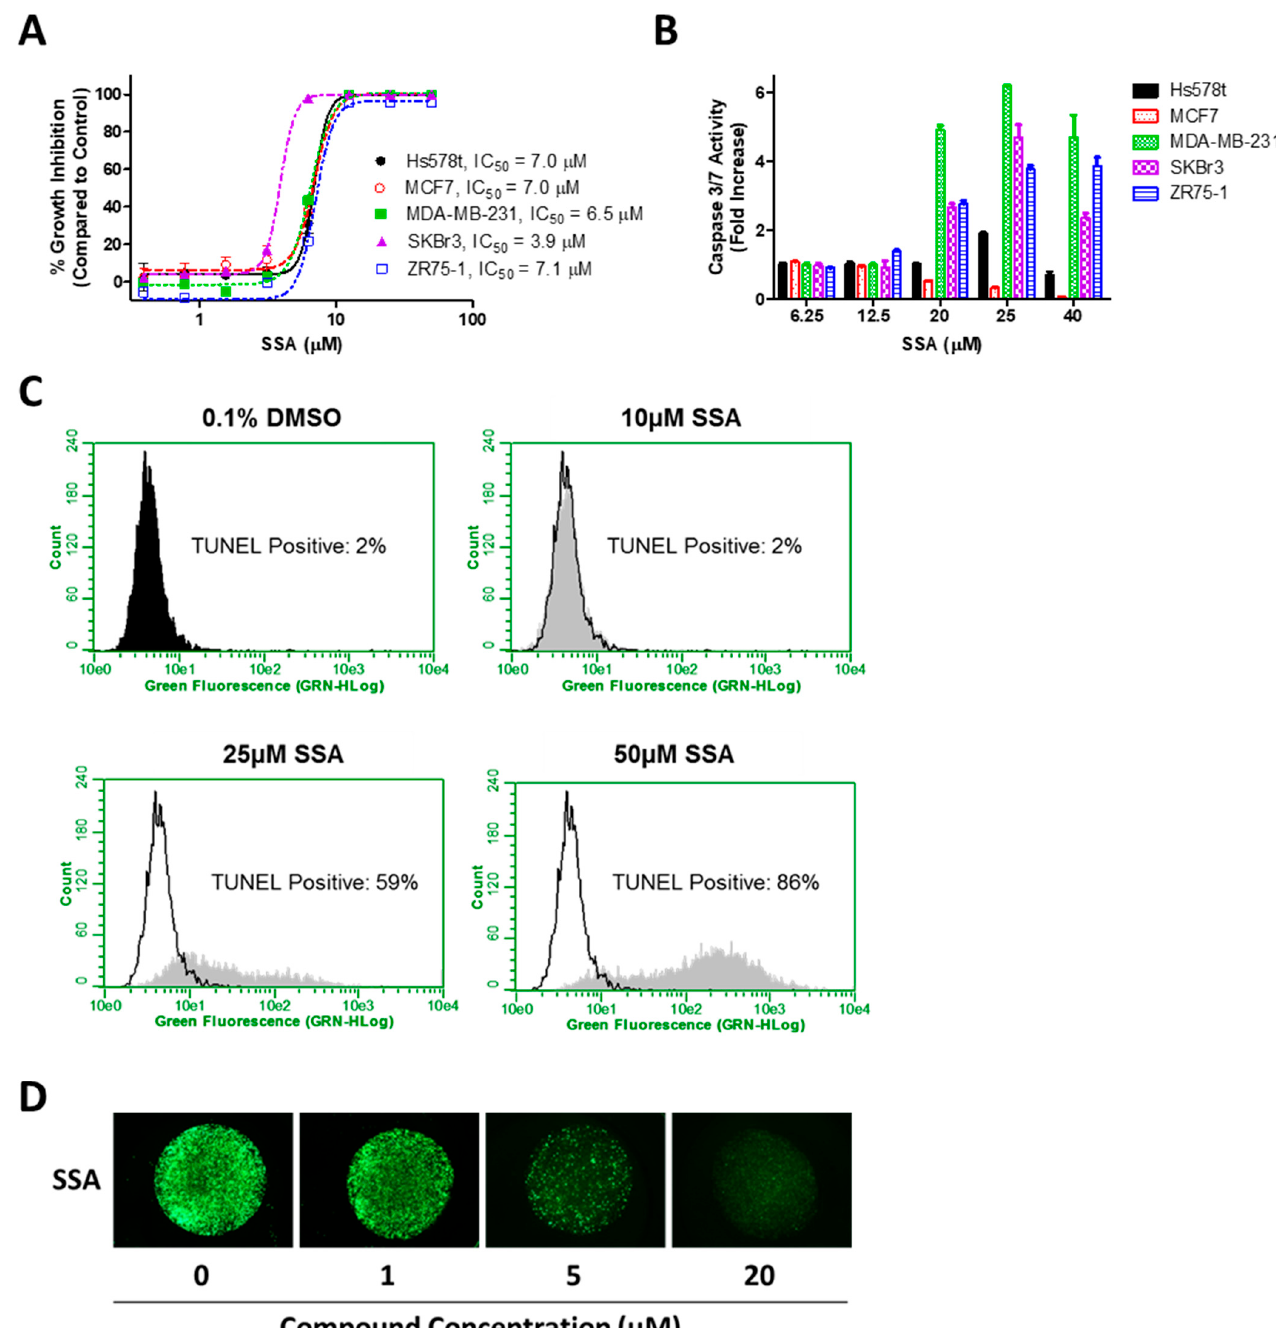
Figure 2. In vitro anticancer activity of SSA. ( A ) Effect of SSA on 2D growth of human breast cancer cell lines after 72 h of treatment. ( B ) Effect of SSA on the activity of initiator caspases 3 and 7 in human breast cancer cell lines after 6 h of treatment. ( C ) Effect of SSA on late apoptosis, as measured by DNA fragmentation via TUNEL assay in SKBr3 breast cancer cells after 24 h of treatment. ( D ) Live imaging via calcein AM staining of MDA-MB-231 breast cancer cells grown in 3D HuBiogel